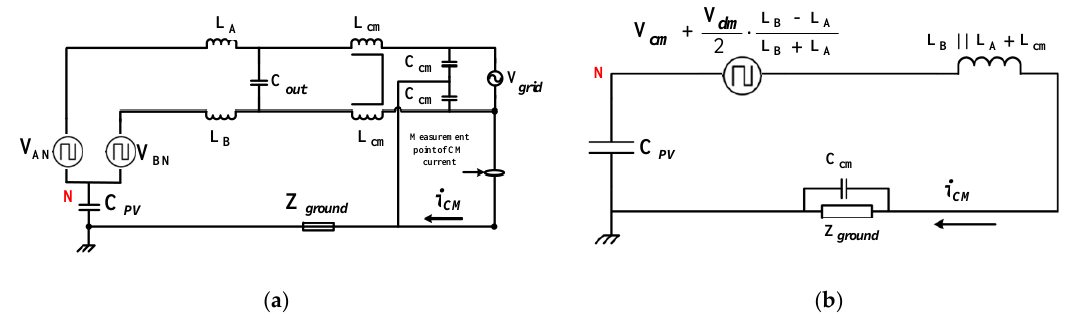
Figure 7. ( a ) CM equivalent circuit of Figure 6, ( b ) CMC single loop.